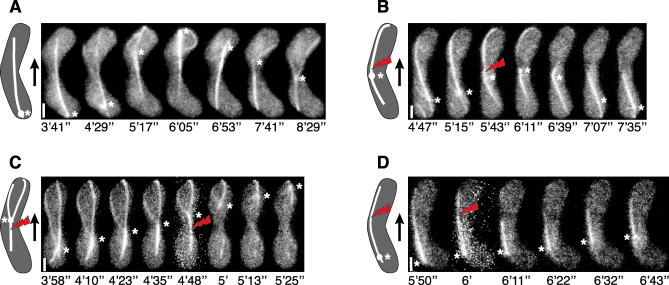
SPB Movement is Driven by Pulling Via the Leading Microtubules(A–D) SPB oscillations in cells expressing Sid4-GFP (SPB marker, indicated by asterisks) and GFP-alpha2-tubulin. Each panel shows selected images from a time-lapse sequence of a cell, together with a scheme of the SPB and microtubules at the time of laser ablation. The red bolt indicates the position of ablation; the black arrows indicate the direction of SPB movement. (SPB position as a function of time for Figure 1B–1D are shown in Figure 6D–6F). (A) Control cell without laser ablation.(B) Laser ablation of the leading microtubules induced a change of direction of the SPB movement (n = 19 out of 21 cells; in the remaining two cells another microtubule pulled the SPB in the same direction).Laser ablation of the (C) trailing microtubules (n = 19/19), or (D) the tip of the leading microtubules (n = 10/10) did not affect the SPB movement. Scale bars, 2 μm.